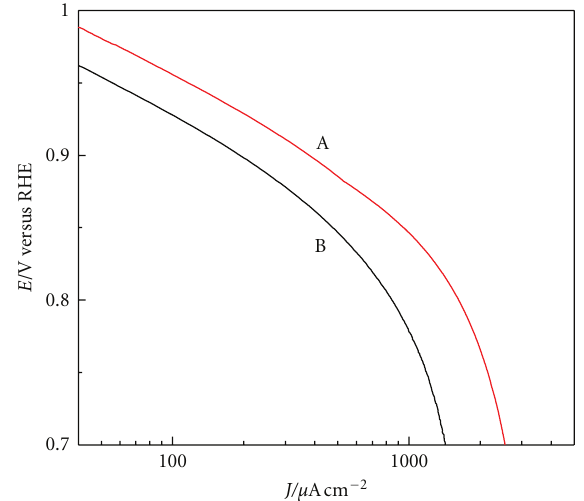
Figure 5: Tafel plots of kinetically controlled ORR currents extracted from Figure